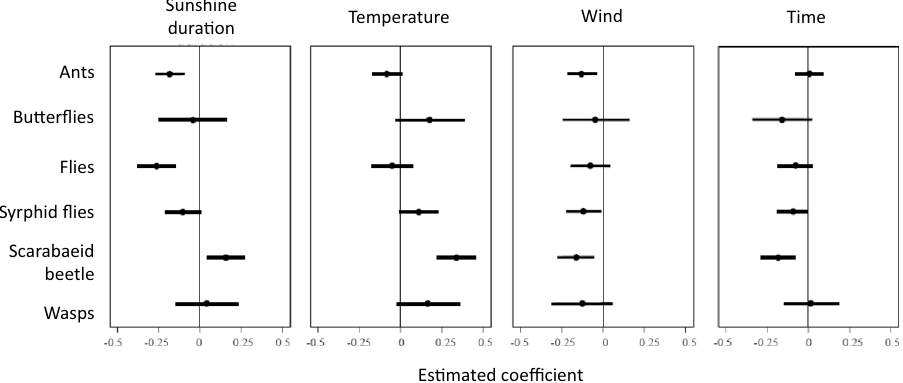
Figure 2. Results of GLM using Baysean analysis showing how weather variables and time infuence abundance of various insects visiting backwheat flowers. Lines indicate 95% credible intervals of the estimated coefficients of variables, and dots are the means of the coefficients. Note that positive coefficients represent positive responses of insects to weather and time variables. See Supplementary Fig. S3 for graphic representation of insect abundance vs independent